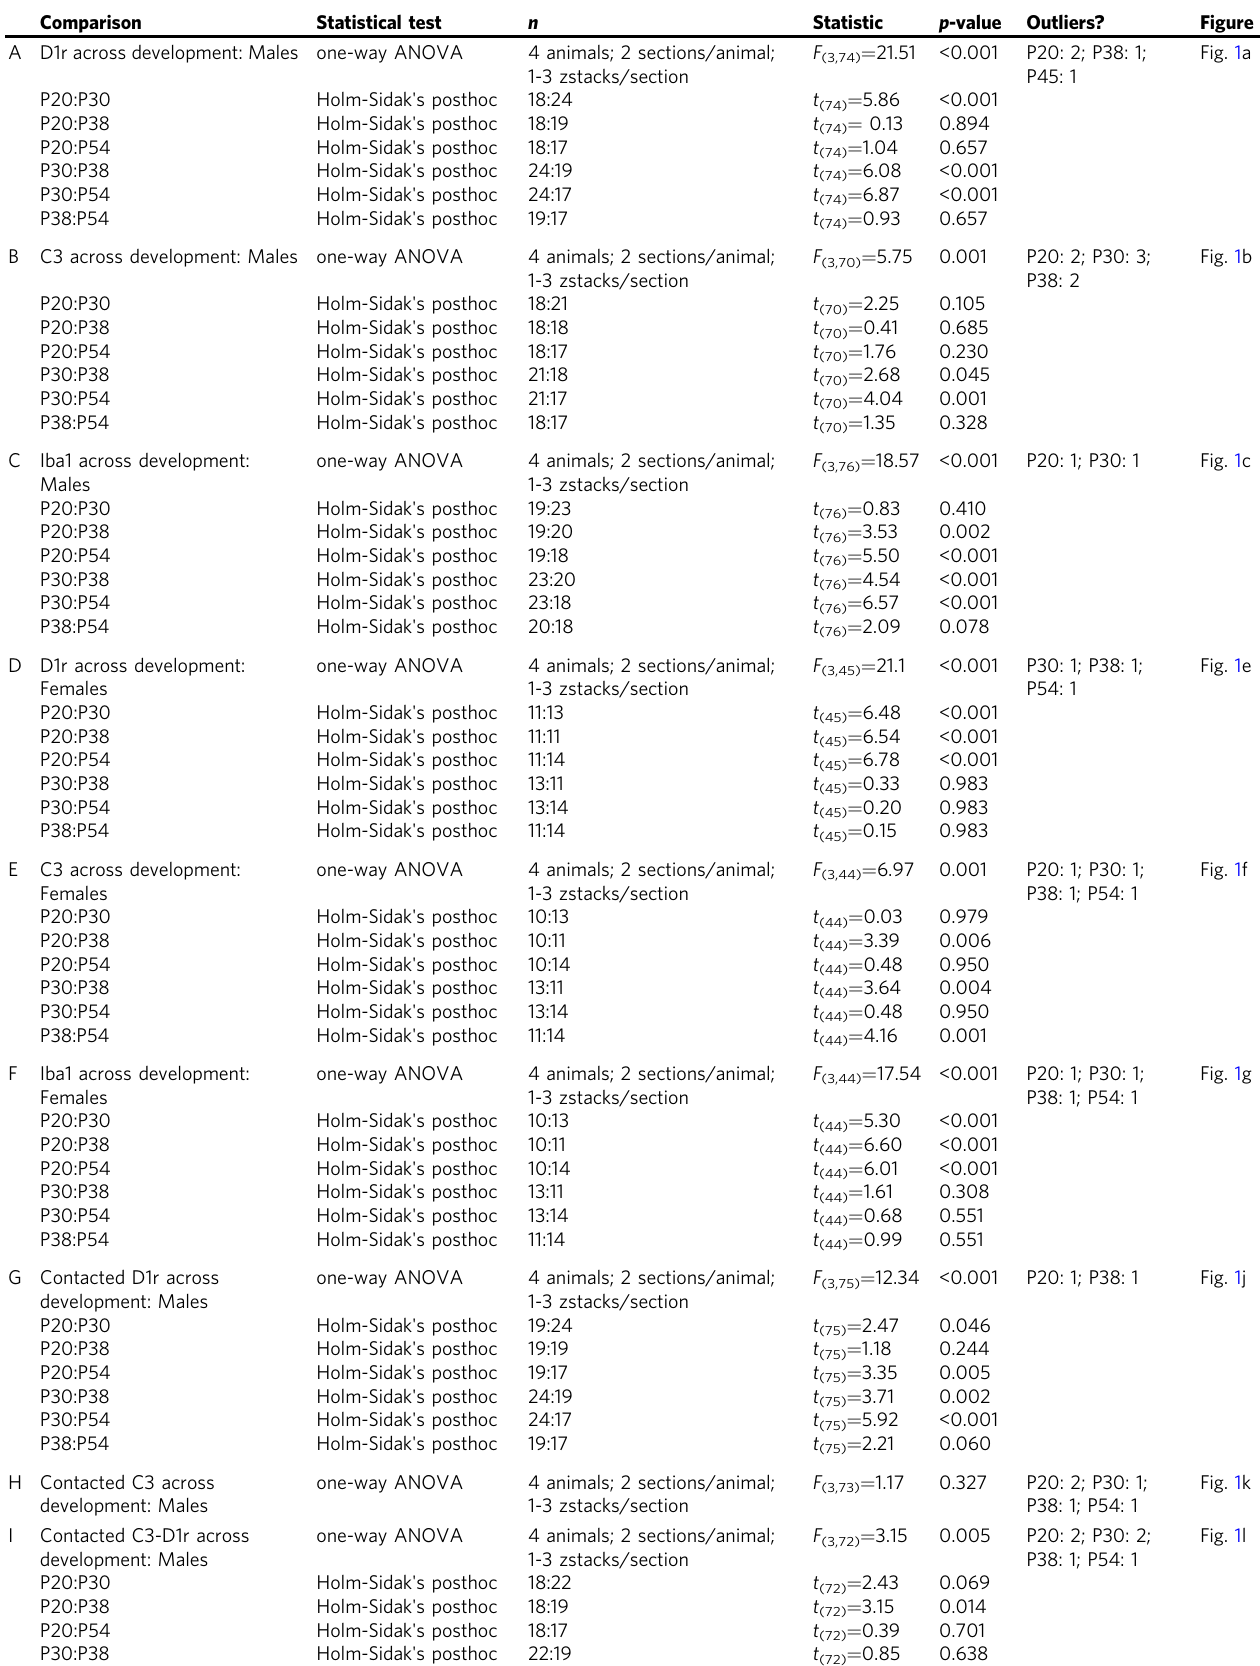
Table 1 Detailed statistics corresponding with Fig.